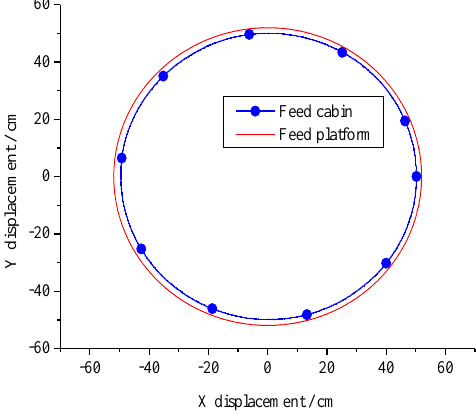
Figure 12. Trajectory projection of the feed cabin and platform in XY -plane.